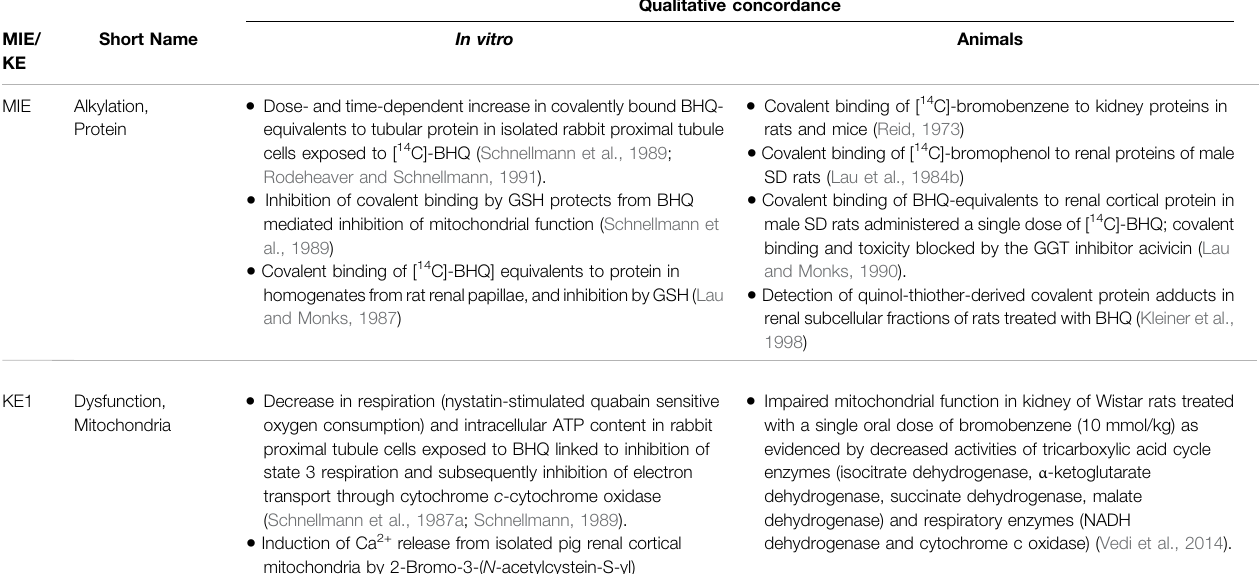
TABLE 7D | Evidence from animaland in vitro studies on bromobenzene and its metabolites 2-bromophenol and 2-bromohydroquinone (BHQ) supporting the key events and qualitative concordance of KEs within this AOP. (Data on human toxicity of bromobenzene are not available (EPA, 2009).). Qualitative